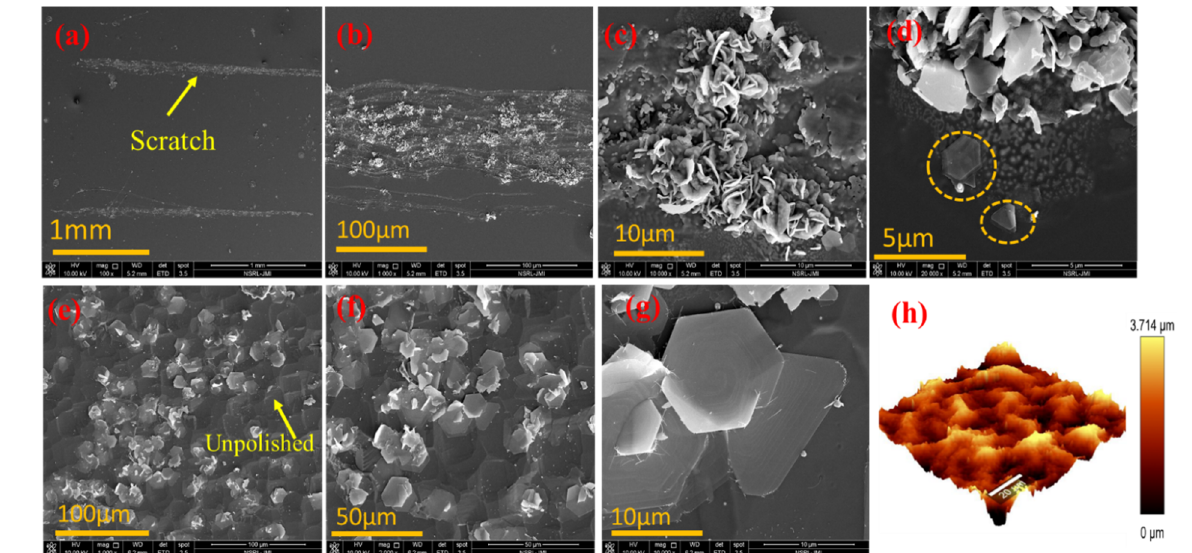
Figure 11. FESEM micrographs of WS 2 grown on scratch marks made on polished surface of Si wafer ( a – d ) and WS 2 grown on unpolished Si wafer ( e – g ). In both cases, other CVD growth parameters were constant. ( h ) The optical profilometer image (surface microscopy) of the GO coated sample surface before WS 2 deposition. The scale bar indicates the surface roughness of the sample close to 3.72 μ m .